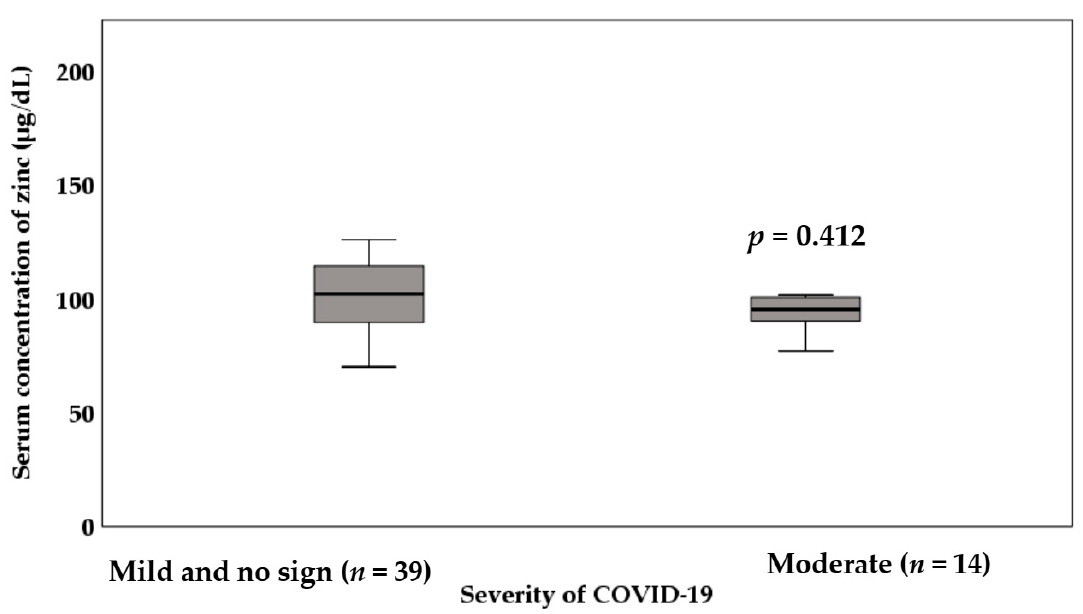
Figure 4. The comparison of the serum concentration of zinc between infected patients with different severity of COVID-19. An independent sample t -test was applied to analyze data. We did not find any significant difference between infected patients with asymptomatic and mild illness and patients with moderate illness in terms of serum concentration of zinc.